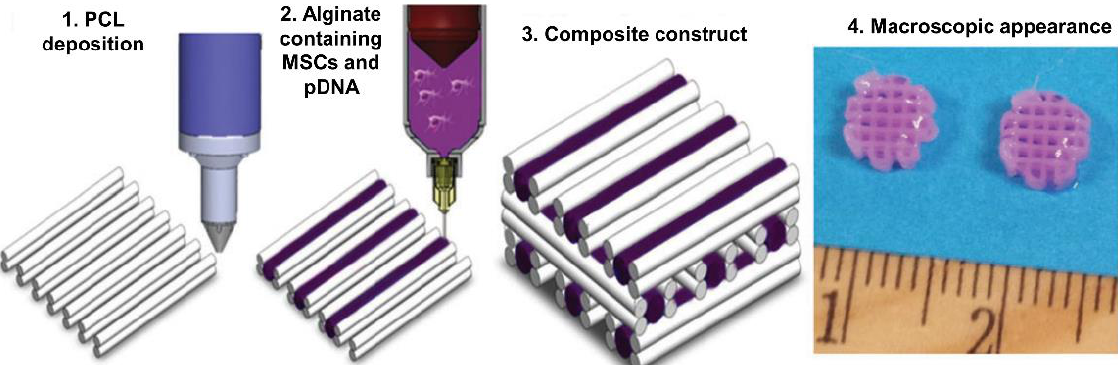
Figure 11. Schematic representation of the bioprinting process with co-printing of PCL and the bioprinting of the bio-ink composed of alginate, MSCs, and nHAP-pDNA complexes. Adapted from [79].